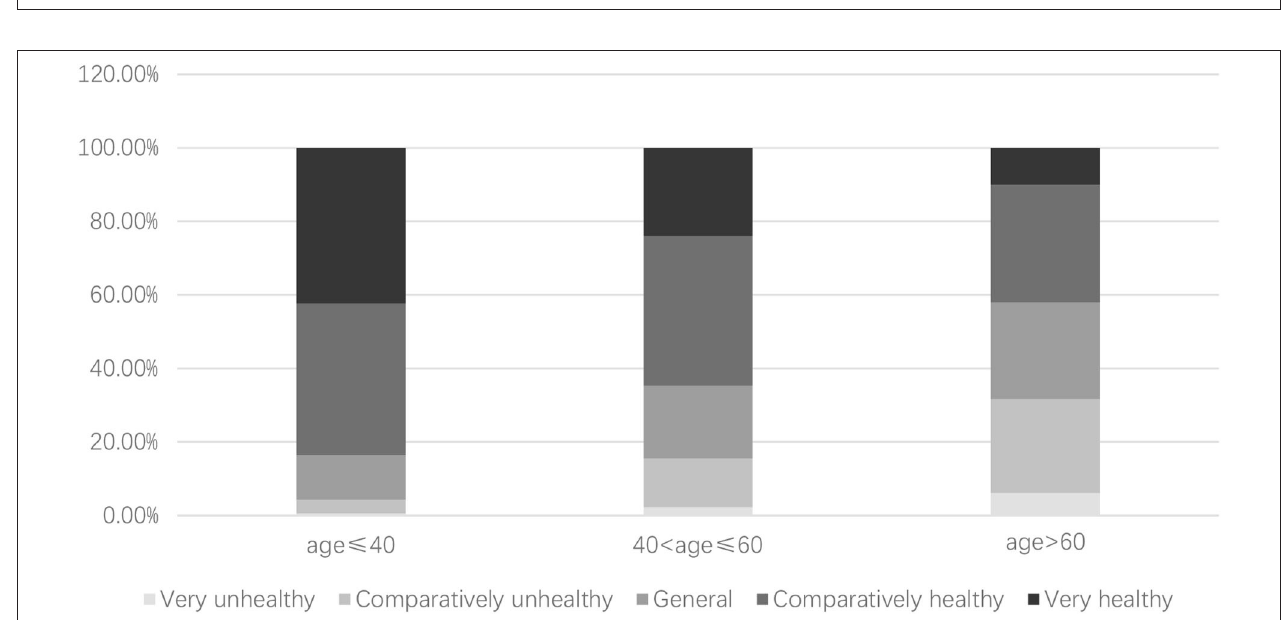
FIGURE 2 | Health conditions among residents of different age